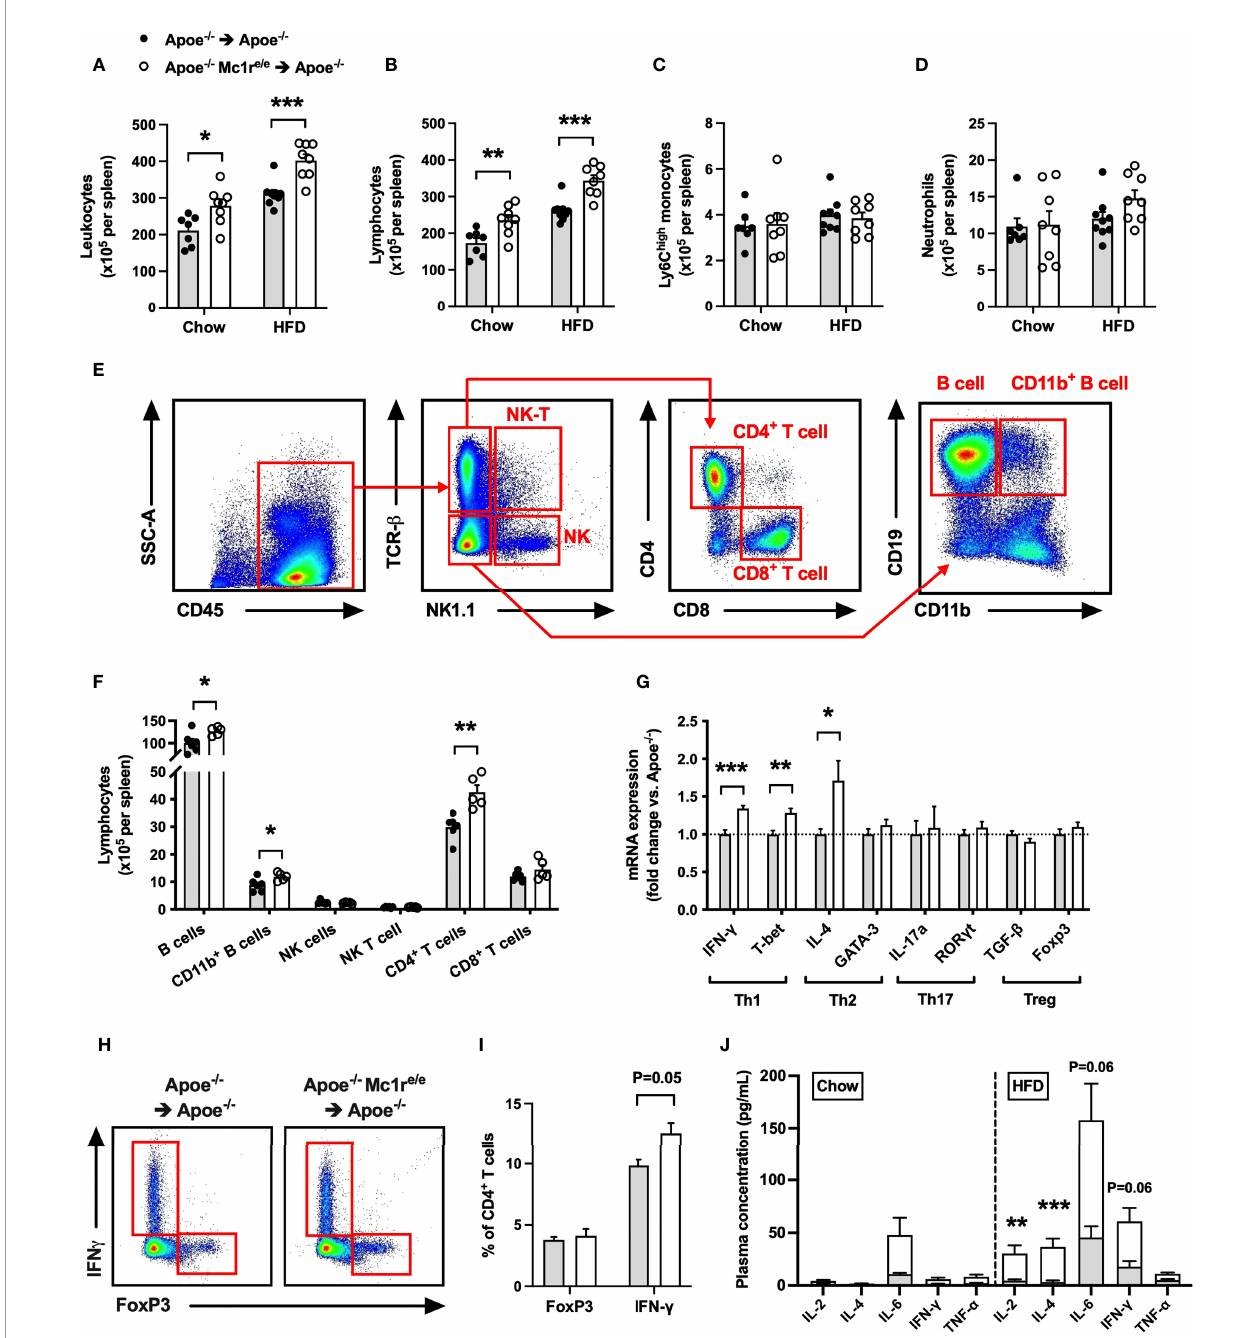
FIGURE 3 | Increased leukocyte and lymphocyte counts in the spleen of Apoe -/- mice reconstituted with MC1-R de fi cient BM. (A – D) Quanti fi cation of total leukocytes (CD45 + ), lymphocytes (CD45 + , CD11b - ), Ly6C high monocytes (CD45 + , CD11b + , CD115 + and Ly6C high ) and neutrophils (CD45 + , CD11b + , Ly6G + ) in the spleen of Apoe -/- recipient mice. (E) Representative dot plots for the gating of NK T cells (CD45 + , TCR b + , NK1.1 + ), NK cells (CD45 + , TCR b - , NK1.1 + ), CD4 + T cells (CD45 + , TCR b + , CD4 + ), CD8 + T cells (CD45 + , TCR b + , CD8 + ), B cells (CD45 + , TCR b - , CD19 + , CD11b - ) and CD11b + B cells (CD45 + , TCR b - , CD19 + , CD11b + ) in the spleen of Apoe -/- BM transplanted mouse. (F) Quanti fi cation of splenic lymphocyte subsets in HFD-fed recipient mice. (G) Quantitative real-time PCR (qPCR) analysis of effector CD4 + T cell markers in the spleen of Apoe -/- and Apoe -/- Mc1r e/e BM transplanted mice. n=8-9 mice per genotype. (H, I) Representative fl ow cytometry results for the gating and quanti fi cation of IFN- g + and Foxp3 + CD4 + T cells (CD45 + , TCR b + , CD4 + ) in the spleen of Apoe -/- and Apoe -/- Mc1r e/e BM transplanted mice. n=4 mice per genotype. (J) Pro-in fl ammatory cytokine concentrations in the plasma of chow- and HFD-fed Apoe-/ - mice. *P < 0.05, **P < 0.01, ***P < 0.001 versus control Apoe -/- mice. Data are mean ±